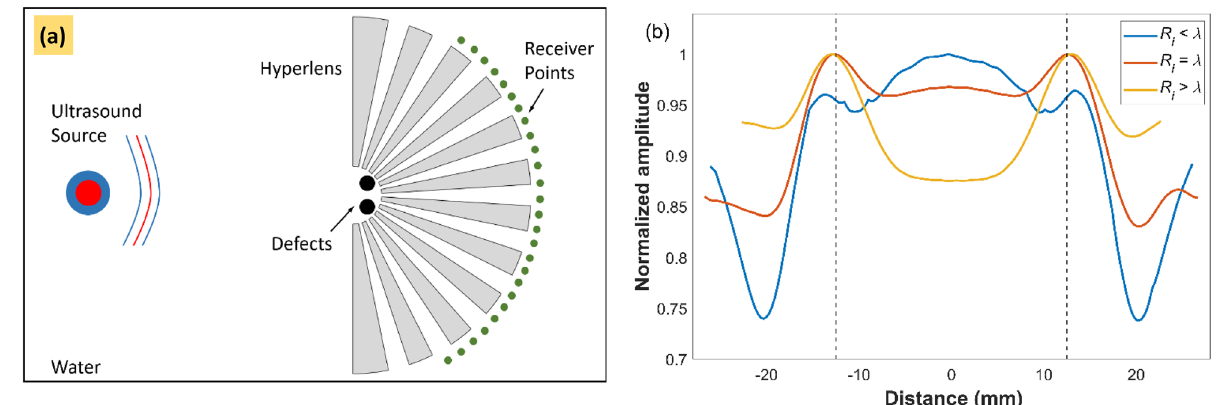
Figure 2. ( a ) Schematic illustrating the 2D FE model of the cylindrical hyperlens concept studied here for imaging defects in the ultrasonic domain. ( b ) Normalized pressure amplitudes obtained at the outer race of the hyperlens. Dotted lines indicate the expected location of the peaks in the magnified